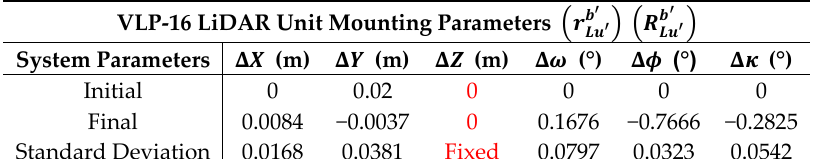
Table 2. Mounting parameters of VLP-16 before and after calibration test 1 (the parameter fixed during calibration is shown in red).